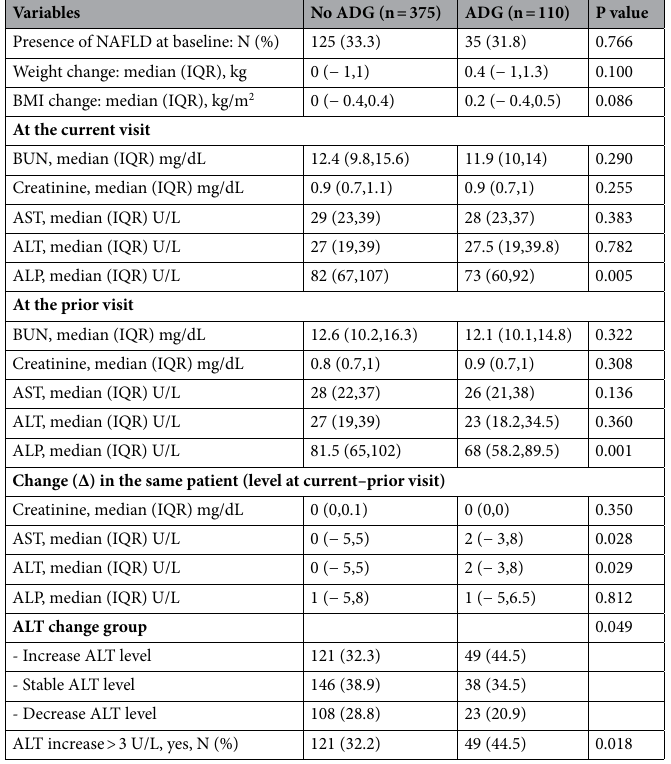
Table 2. Comparison between control group VS ADG group in patients with available laboratory data (N = 486). ADG, andrographolide; ALP, Alkaline phosphatase; ALT, Alanine aminotransferase; AST, Aspartate